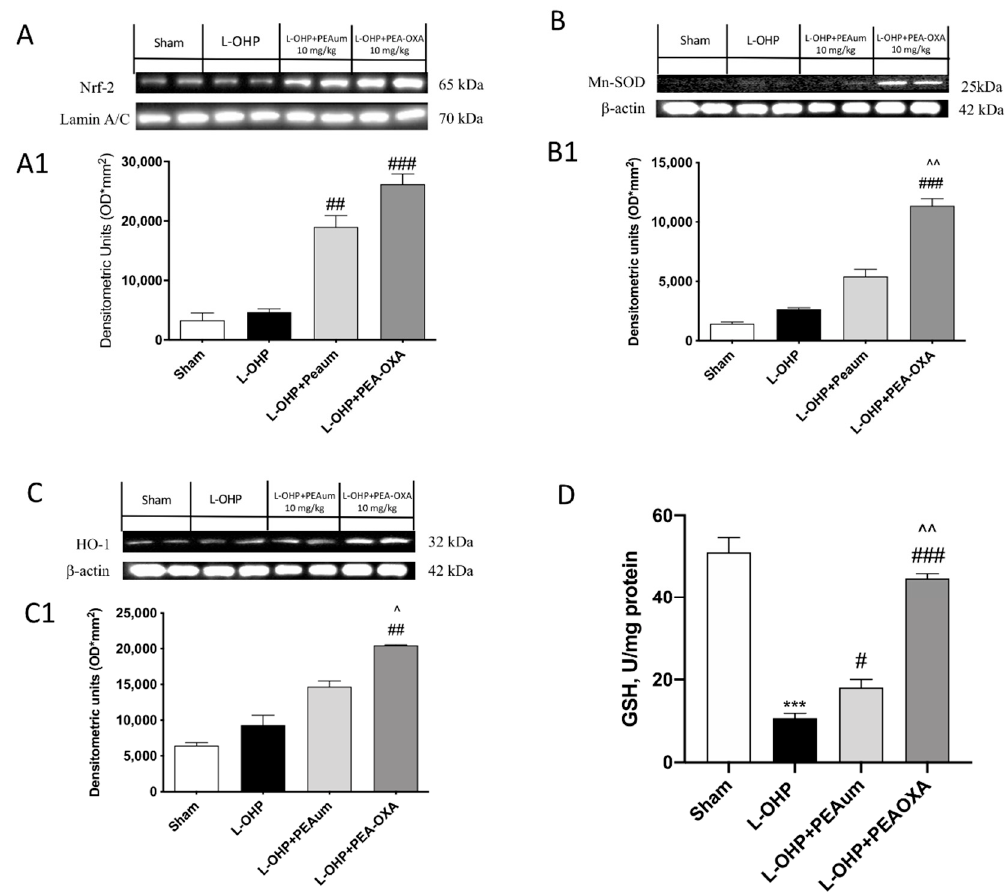
Figure 4. Effect of PEA-OXA on Nrf-2, Mn-superoxide dismutase (MnSOD), and HO-1 expression and reduced glutathione (GSH) levels. The expression of Nrf-2, Mn-SOD, and HO-1 was observed by Western blot analysis in lumbar spinal cord. Nuclear Nrf-2 expression increased following L-OHP injection, compared to sham group ( A ), while PEA-OXA administration, 10 mg/kg, upregulated Nrf-2 activity ( A ). The same result was obtained for MnSOD ( B ) and HO-1 expression, which was notably increased following L-OHP compared to sham groups ( C ), while PEA-OXA treatment significantly upregulated Mn-SOD and HO-1 expression, much more then PEAum ( B , C ). L-OHP decreased GSH levels compared to control group, while PEA-OXA treatment restored GSH levels, much more than PEAum ( D ). Data are means ± SEM of 10 mice for each group. A representative blot of lysates obtained from each group is shown and densitometry analysis of all animals is re- ported ( n = 10 mice from each group). One-way ANOVA test; *** p < 0.001 vs. sham; # p < 0.05 vs. L-OHP; ## p < 0.01 vs. L-OHP; ### p < 0.001 vs. L-OHP; ^ p <0,05 vs. PEAum; ^^ p <0,01 vs. PEAum. 2.5. PEA-OXA Reduced Astrogliosis and IL-17 Production in the Lumbar Spinal Cord We analyzed with immunofluorescence staining the expression of IL-17 in astrocytes, evaluated through Glial fibrillary acidic protein (GFAP). In this study, we demonstrated that L-OHP induced a prominent astrogliosis with the consequent production of IL-17 (Figure 5B,E), compared to sham animals (Figure 5A,E). Instead, treatment with PEAum reduced the number of reactive astrocytes (Figure 5C,E), which was almost completely reversed by PEA-OXA (Figure 5D,E).